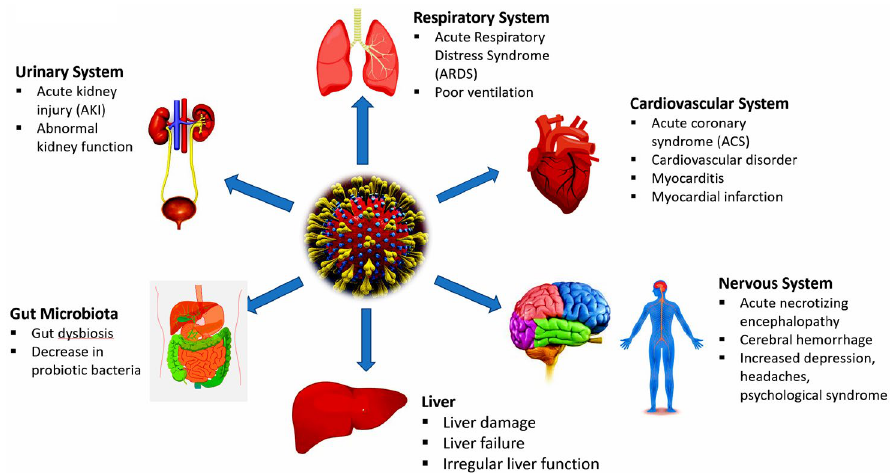
Fig. 1. Effects of COVID-19 on major parts of the human